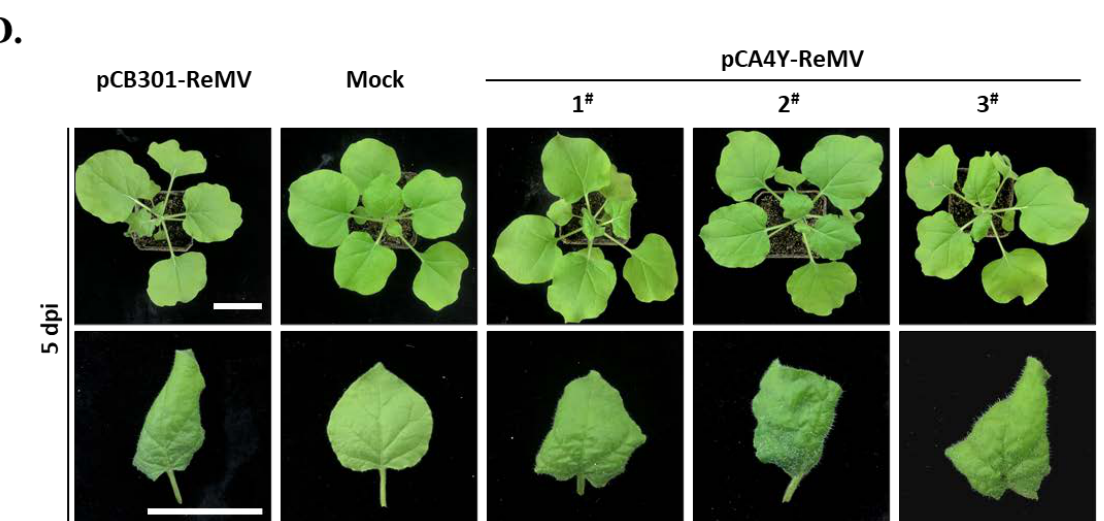
Figure 5. Construction of the Rehmannia mosaic virus (ReMV) infectious cDNA clone using the established triple-shutting vector-based yeast HR recombination. ( A ). Genome organization of the ReMV. The coding strategies were similar to the YoMV described in Figure 4A. ( B ). Illustration of the detailed construction strategies for the ReMV single cDNA. The cDNA was divided into three parts: fragments 1 is 2,159 bp (Frag. 1), fragment 2 is 2161 bp (Frag. 2), and fragment 3 is 2121 (Frag. 3). ( C ). PCR validation of the positive ReMV infectious cDNA clone with specific pairs of primers listed in Supplementary Table S1. The detailed meaning of the Frag. 1, Frag 2, and Frag. 3 were shown in ( B ). ( D ). Symptoms of the ReMV infectious cDNA clones-inoculated N. benthamiana plants after 5 dpi. The pCB301-ReMV-inoculated plants were treated as positive control. The mock, and numbers shown were the same meaning in Figure 4D. Bar indicates 3 cm. ( E ). RT-PCR and Western blot detect the infectivity of the newly constructed ReMV infectious clones. Specific pairs of primers and antibodies for the CP ReMV coding gene and protein were used in the assays, respectively.